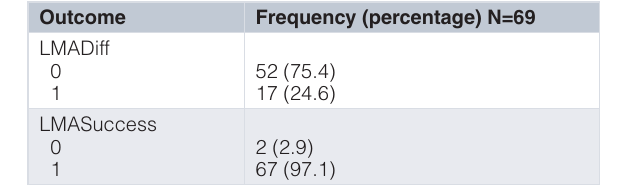
Table 4. Summary statistics for LMADiff and LMASuccess.